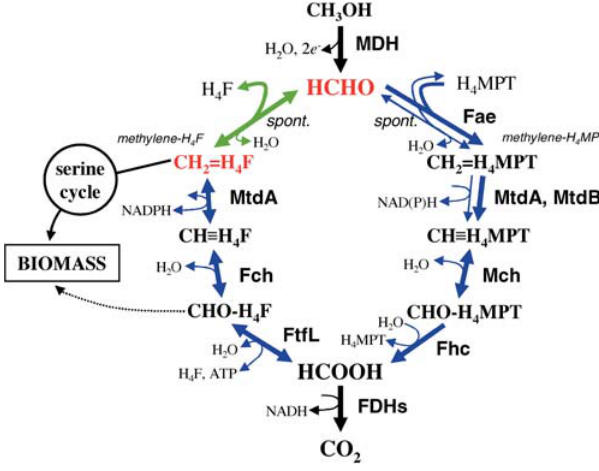
Figure 1. Formaldehyde Metabolism of M. extorquens AM1 Three modules work to provide two cellular outputs: formaldehyde assimilation and dissimilation. The direct condensation of form- aldehyde with H 4 F is shown in green. A second proposed route for generating methylene-tetrahydrofolate (methylene-H 4 F), the consec- utive action of the H 4 MPT and H 4 F modules is shown in blue. Fae, formaldehyde activating enzyme; Fch, methenyl H 4 F cyclohydrolase; FDH, formate dehydrogenase; Fhc, formyltransferase/hydrolase com- plex; FtfL, formyl H 4 F ligase; H 4 MPT, tetrahydromethanopterin; Mch, methenyl H 4 MPT cyclohydrolase; MDH, methanol dehydrogenase; MtdA, methylene H 4 F/H 4 MPT dehydrogenase; MtdB, methylene H 4 MPT dehydrogenase. Spontaneous and reversible reactions are